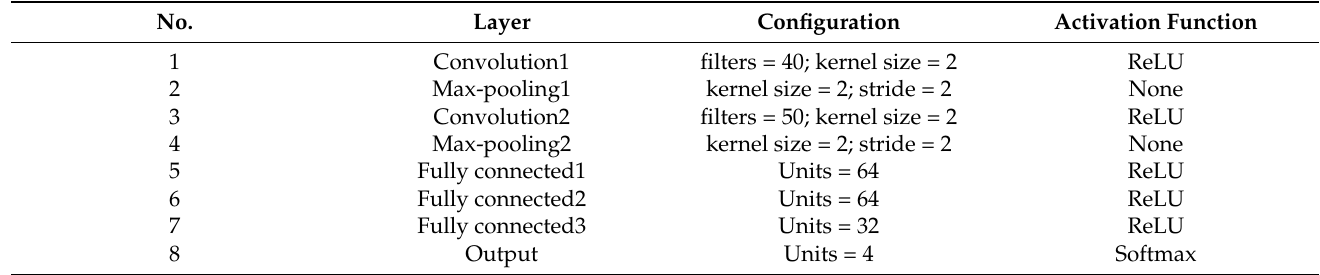
Table A2. Layer configuration of the 1DCNN model (time step = 3 s, data sets = head + eye).